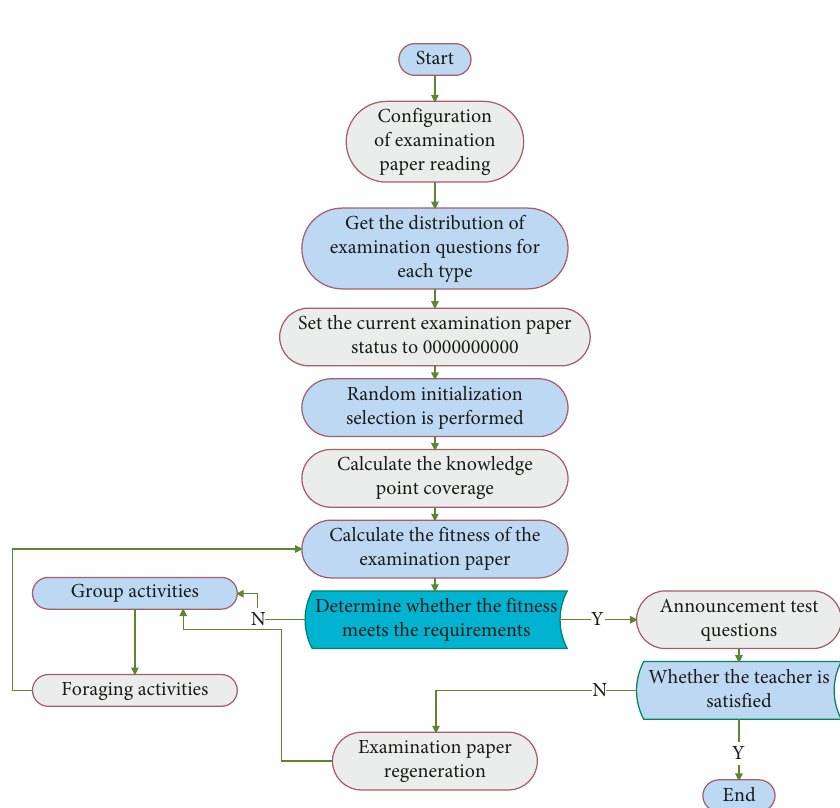
Figure 6: Flow chart of intelligent test paper